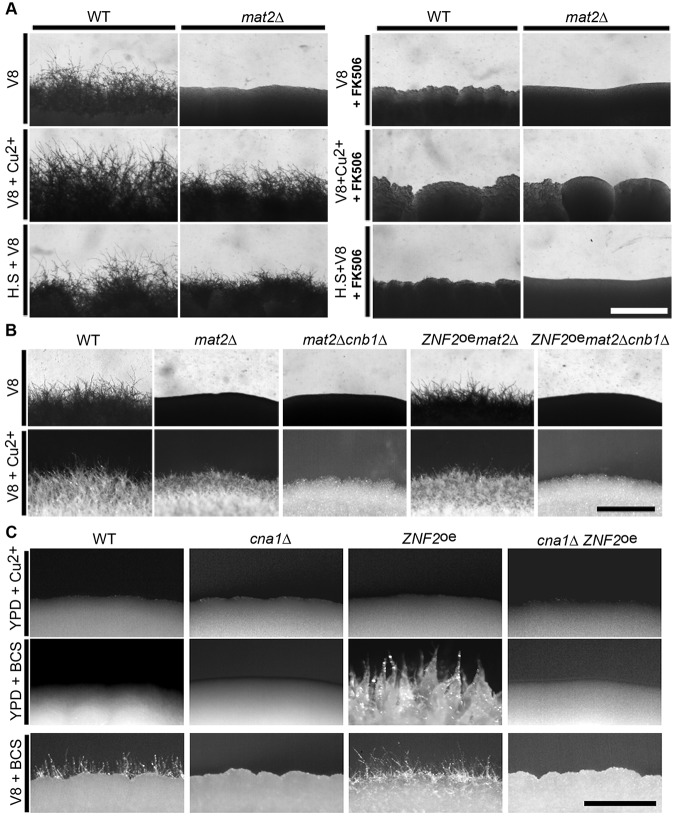
Filamentation requires both Znf2 and calcineurin.(A) WT and mat2Δ were incubated on V8 medium, V8+copper medium, or V8 medium after prior exposure to high temperature in the absence or the presence of the calcineurin inhibitor FK506. Pictures were taken after 1 week of incubation in the dark at 22°C. (B) WT, mat2Δ, mat2Δcnb1Δ, PGPD1-ZNF2 mat2Δ, and PGPD1-ZNF2 mat2Δcnb1Δ strains were cultured on V8 or V8+Cu2+ medium. (C) WT, cna1Δ, PCTR4-ZNF2, and cna1Δ PCTR4-ZNF2 strains were cultured on ZNF2-suppressing YPD+Cu2+ medium, and ZNF2-inducing YPD+BCS or V8+BCS medium. Scale bars: 500 μm.